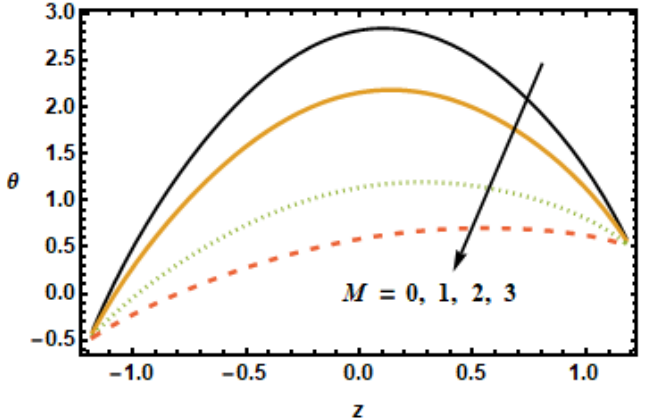
Figure 14. Effects of Hartman number M on θ .